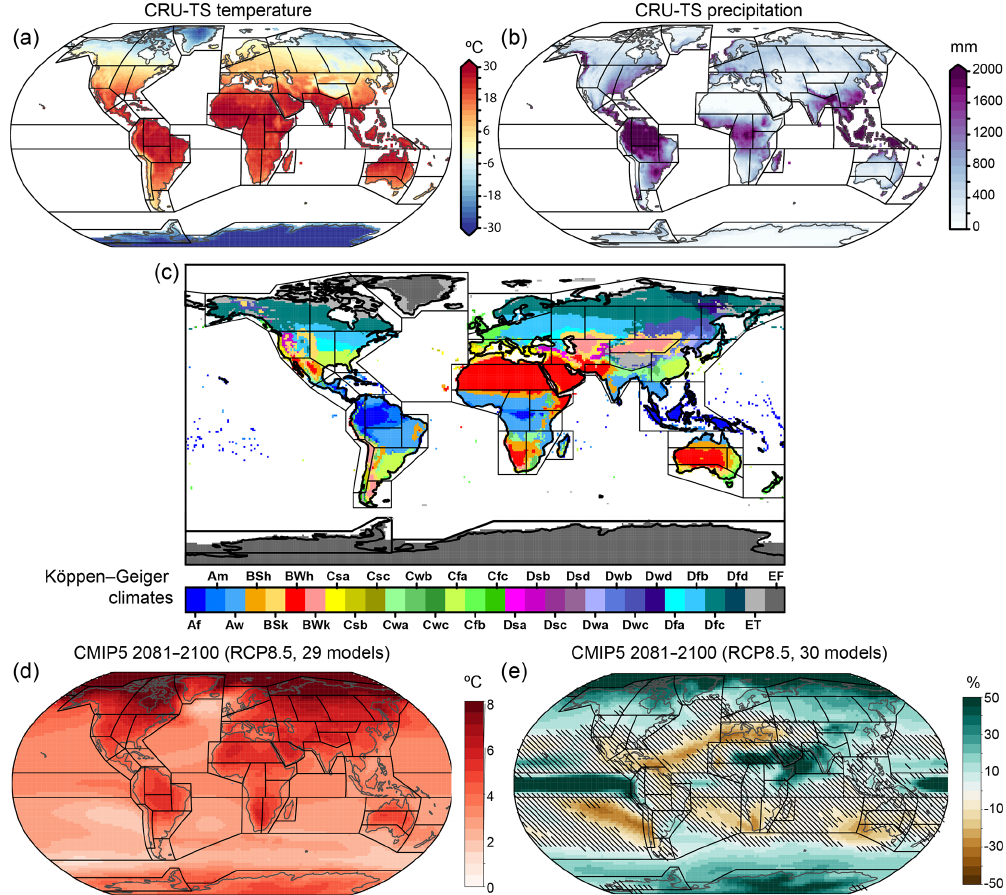
Figure 2. (a) Global mean temperature, (b) accumulated precipitation and (c) Köppen–Geiger climate classification from the CRU-TS dataset for the period 1981–2010 (data for Antarctica are filled with the EWEMBI dataset). This information is used to characterize the regional climate consistency of the reference regions (solid lines). (d, e) Climate change projections for temperature and precipitation, respectively, from the CMIP5 curated dataset for RCP8.5 2081–2100 w.r.t. the AR5 modern climate baseline 1986–2005. Hatching indicates weak (less than 80%) model agreement on the sign of the